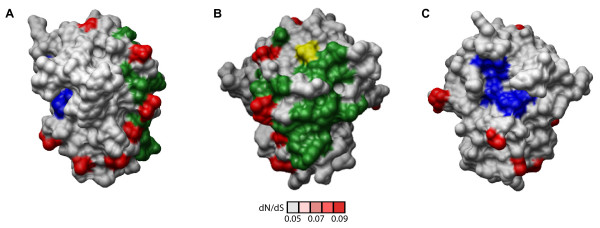
Location of diversifying residues and functional residues in the 3C protease. Three different views of diversifying residues in the HRV2 3C protease relative to protease active site residues (blue; (Matthews et al., 1999)) and residues implicated in RNA binding and VPg binding (green; (Matthews et al., 1999). A. Relative to both protease and RNA binding/VPg interacting domain. B. Relative to RNA binding/VPg interaction domain. C. Relative to the proteolytic active site (Matthews et al., 1999). Diversifying residues are shown in red, shaded according to their corresponding dN/dS values indicated by the scale bar; yellow, diversifying residues that directly overlap functional residues.